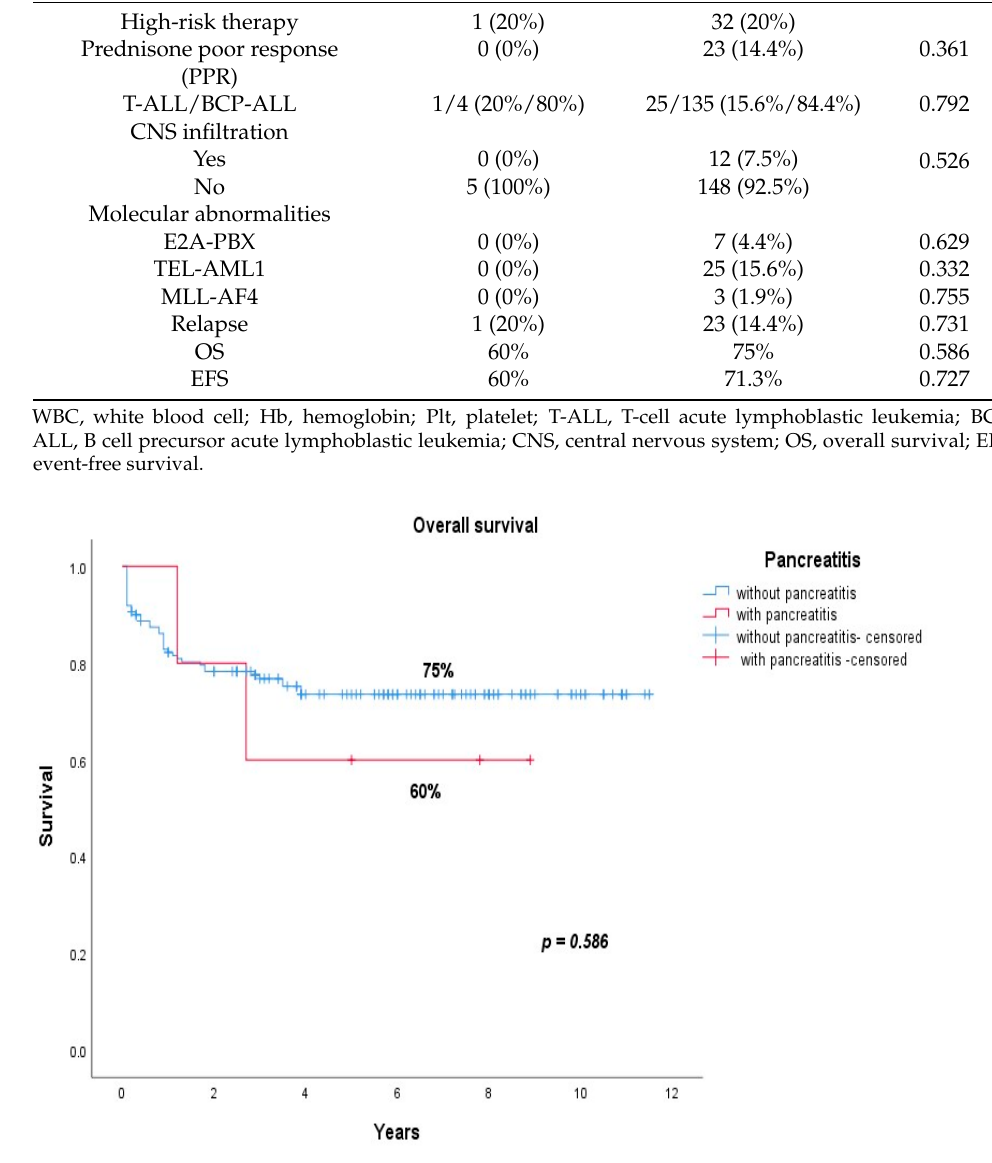
Figure 5. Overall survival of patients who had pancreatitis (red line) compared to those who did not (blue line).